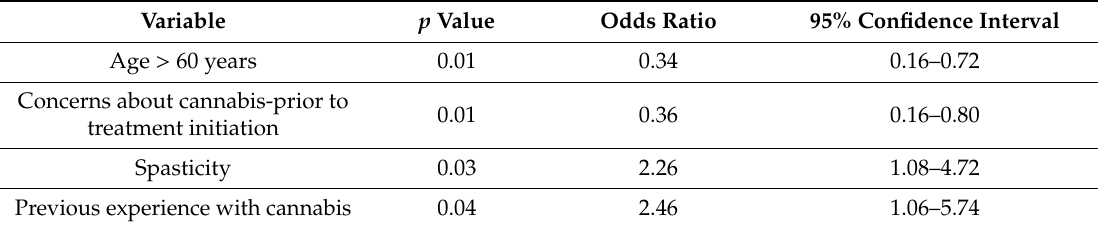
Table 2. Multivariate analysis for treatment response at six months.